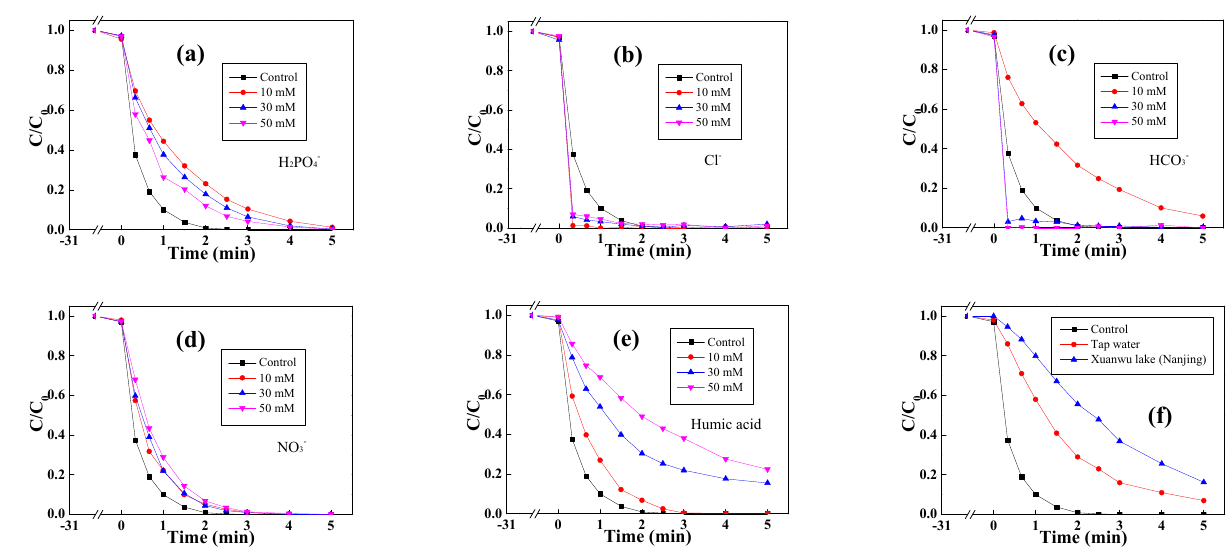
Figure 6. Impact of ( a ) H 2 PO 4 − , ( b ) Cl − , ( c ) HCO 3 − , ( d ) NO 3 − , ( e ) humic acid, and ( f ) natural water on the performance of N-PPB600 ([catalyst] 0 = 0.5 g/L, [BPA] 0 = 0.02 mM, [PMS] 0 = 1.5 mM). The active species generated in the reaction system which dominated the BPA degra- dation was investigated through scavenging test with the results shown in Figure 7a. It was observed that both methanol (MeOH) and tert-butyl alcohol (TBA) did not show any inhibition effect to BPA degradation, indicating that no radical species was generated in the reaction system. When the trapping agent was changed to L-histidine and para- benzoquinone (p-BQ), the BPA degradation could be completely inhibited. Since these two agents were both non-radical scavenger which could effectively trap singlet oxygen ( 1 O 2 ) in the solution [31], this meant the N-PPB600/PMS system was a 1 O 2 dominated system for BPA degradation. This could also explain why N-PPB600 could kept its catalytic activity at various water matrices since 1 O 2 was not much influenced by the variation of external environment.